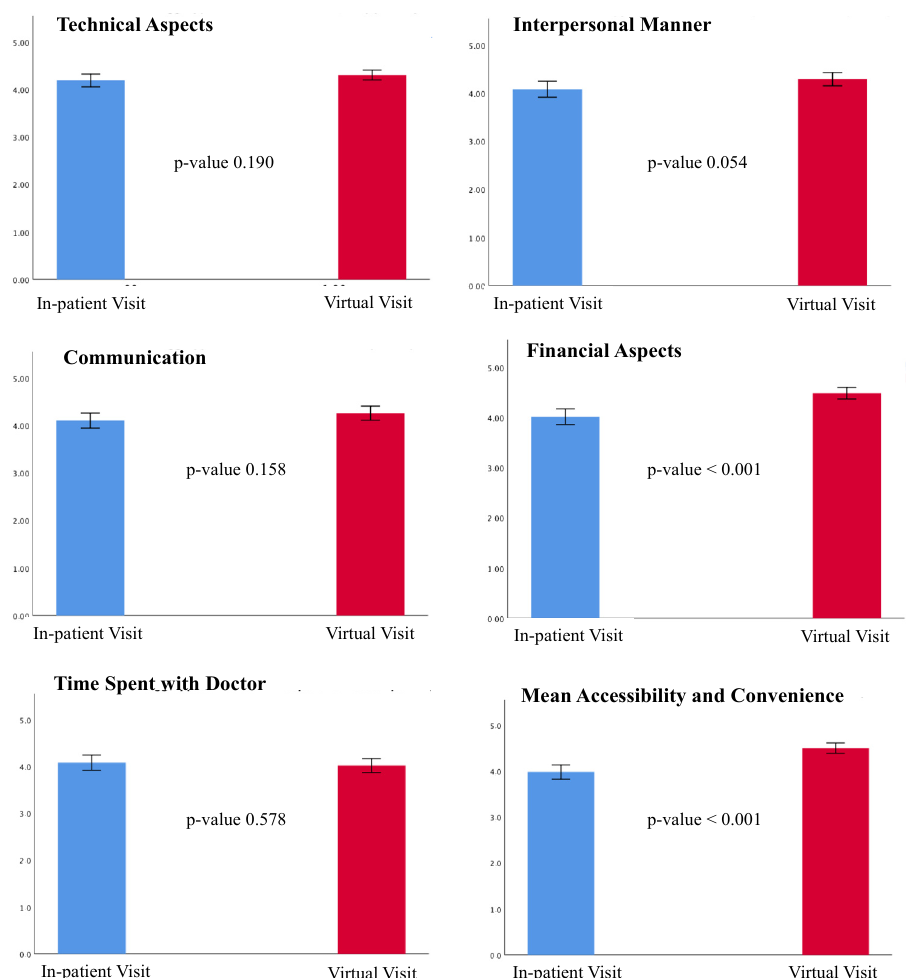
Figure 2. Results from the PSQ-18. The total PSQ-18 score and the scores for the seven subscales are shown. Results are expressed as the means and standard deviations. Blue color represents the in-patient group; red color represents the virtual visit group. The p -value for each comparison is shown. A p -value < 0.05 was considered statistically significant. PSQ-18: Patient Satisfaction Ques- tionnaire-18.